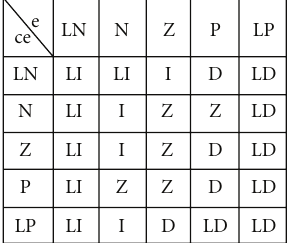
Figure 8: Rule matrix of the FLC.